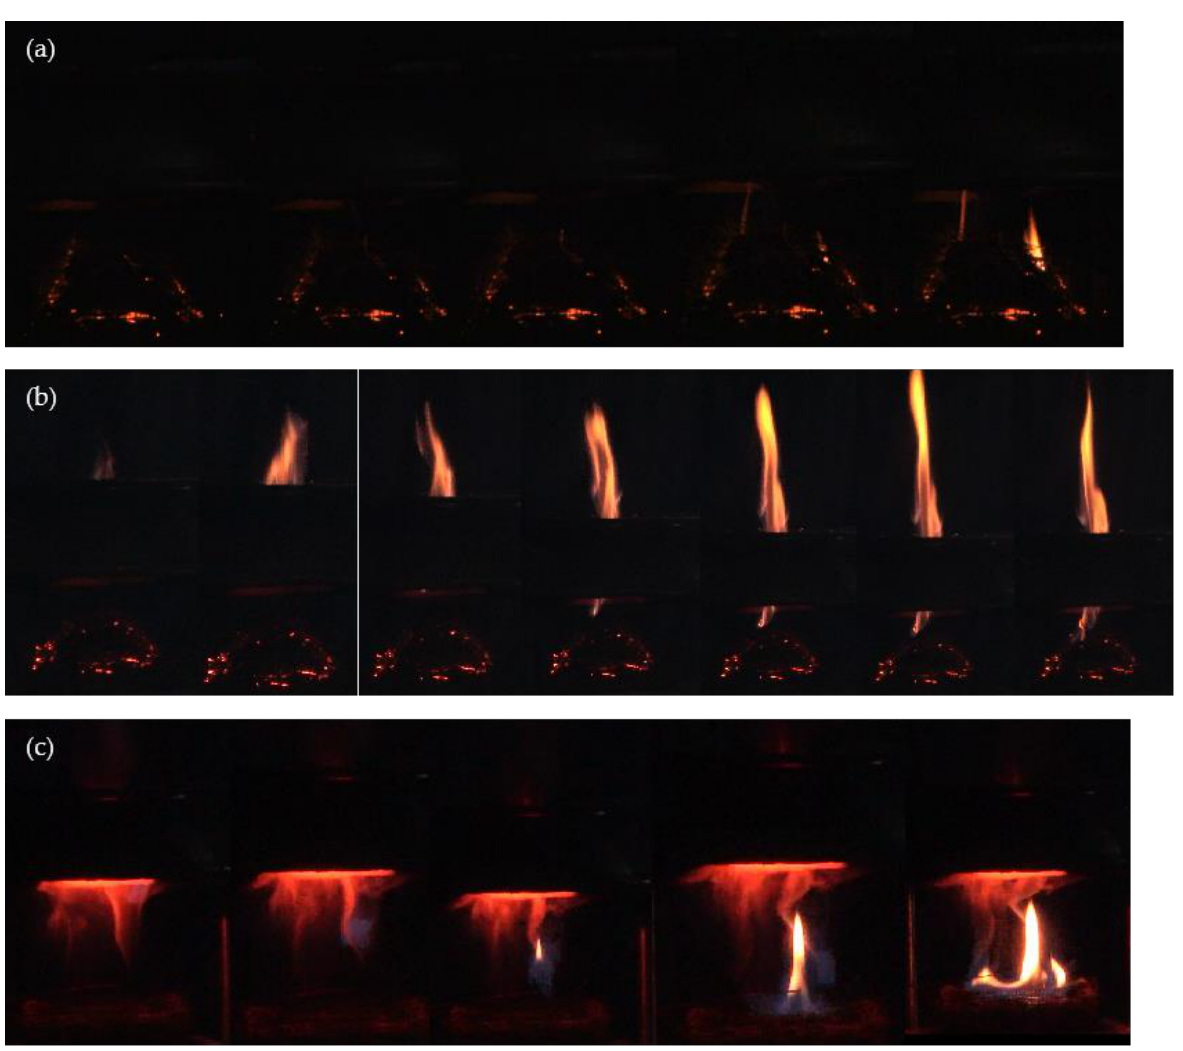
Figure 4. Timelapse images of ignition phenomena of pine needle: ( a ) D = 45 mm; ( b ) D = 50 mm; ( c ) D = 60 mm.